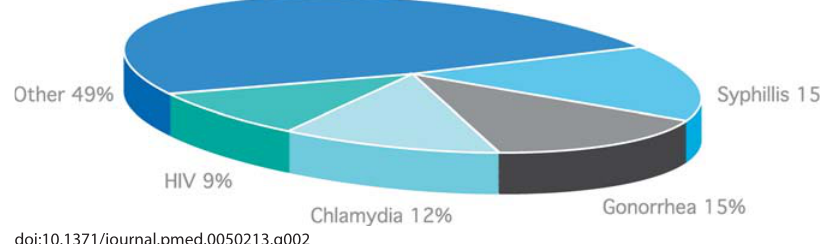
Figure 2. E-Cards Sent, By Disease, 2006–2007